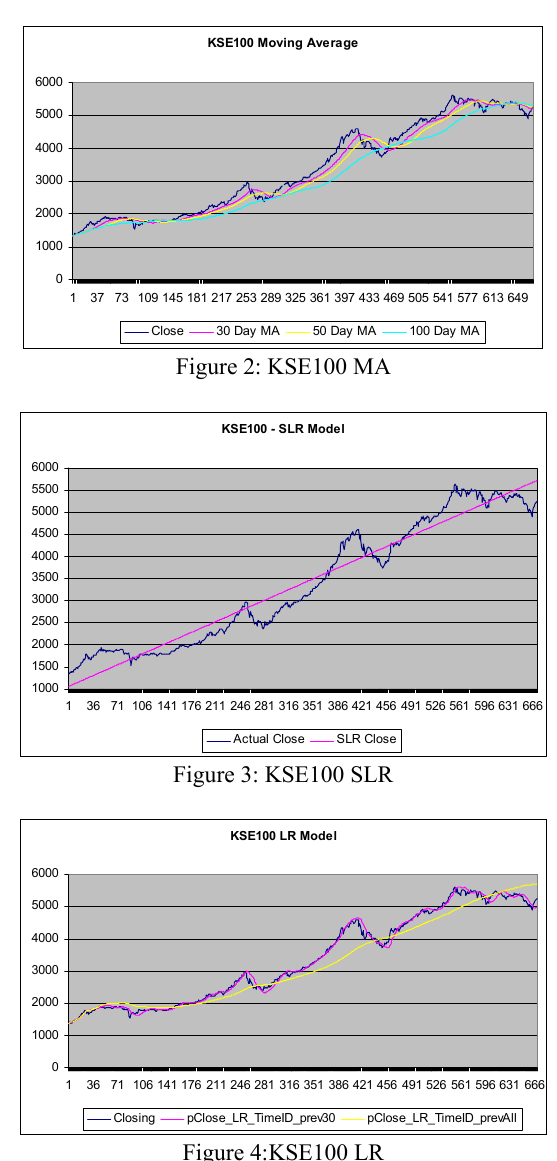
Figure 4:KSE100